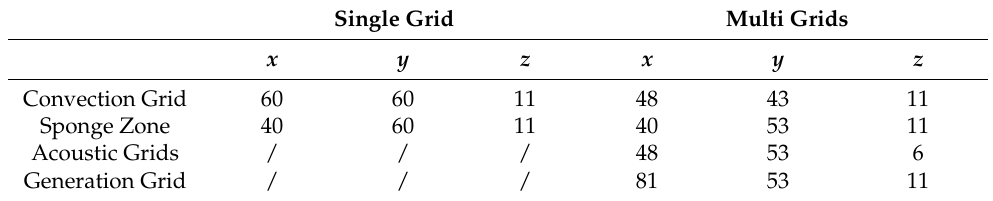
Table 3. Number of points per core for each configuration in every direction (see Figures 4 and 5). Single Grid Multi